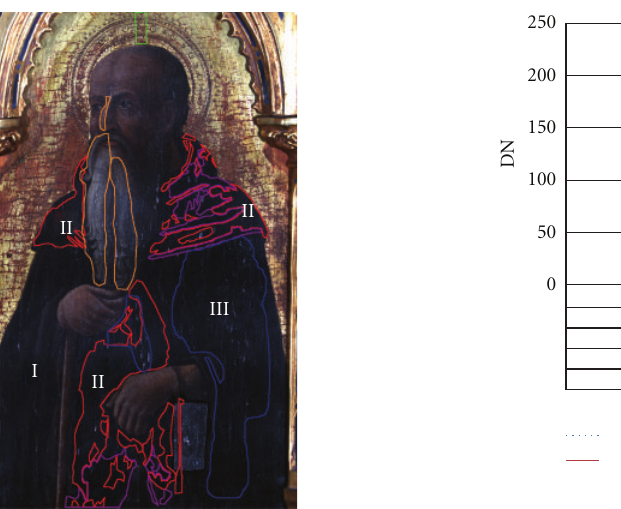
Figure 8: RGB image with additional information provided by postprocessing with respect to the data input (see Table 1).